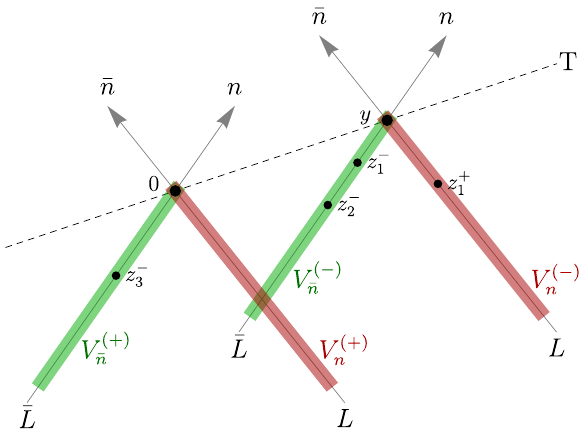
Figure 3 . Spatial configuration of the operators contributing to an effective operator (4.1) in the case of DY kinematics. The dots represent insertion of collinear (green) and anti-collinear (red) fields. The thick colored lines are light-rays along which the operators are